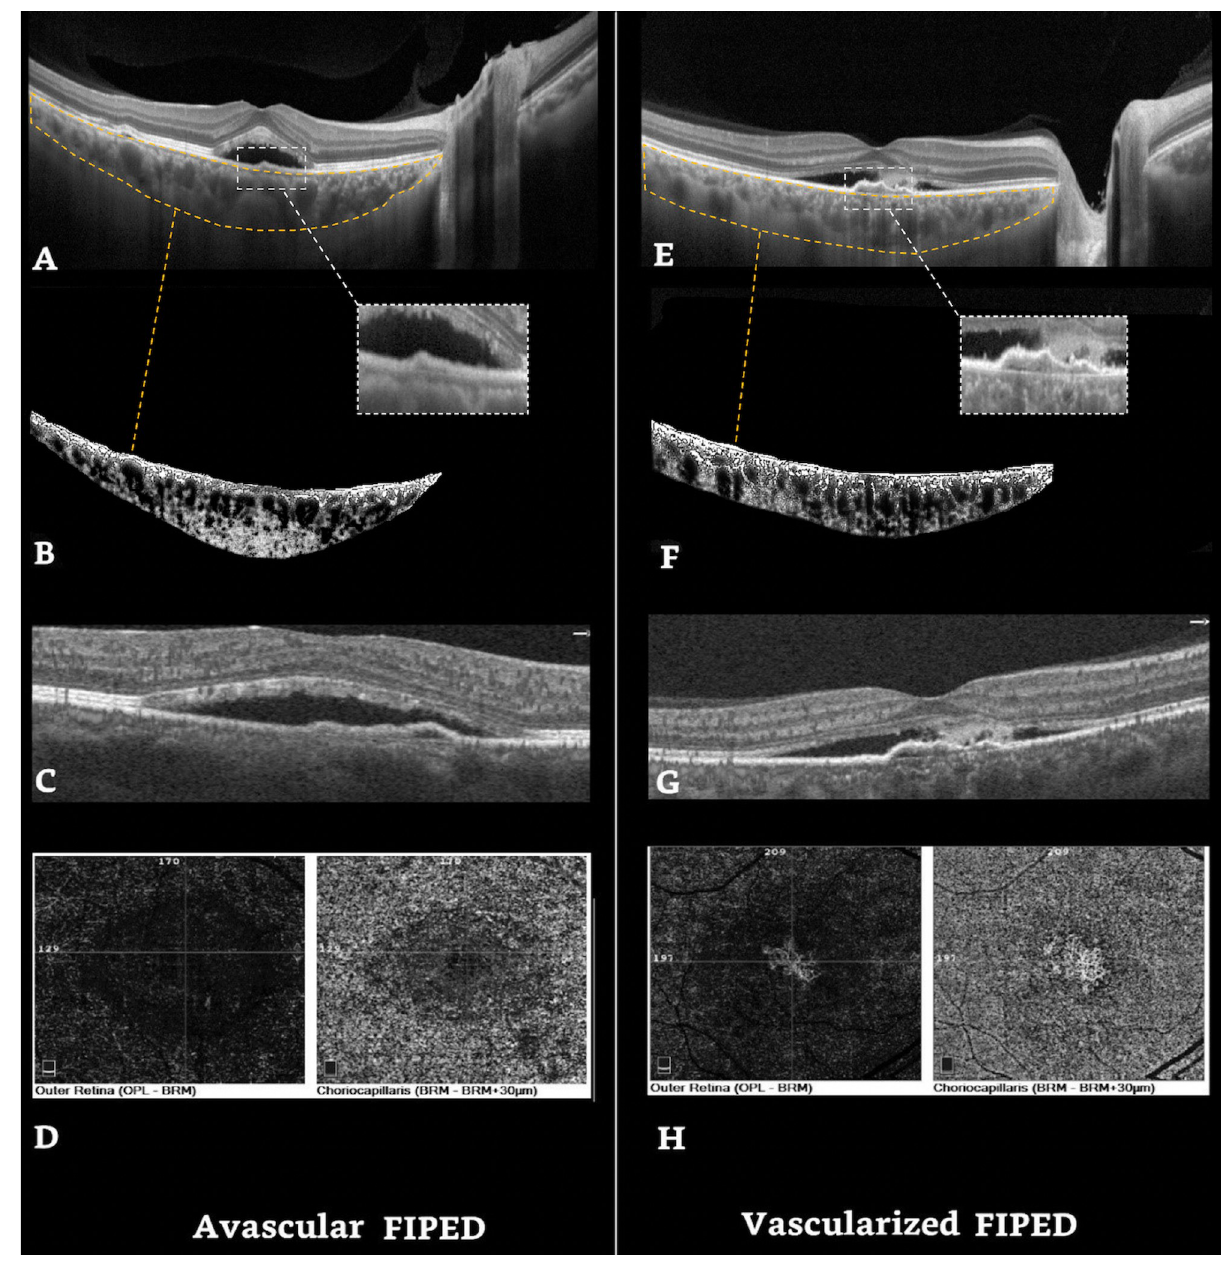
Fig 1. Right eye EDI-OCT and OCTA images of chronic CSC in a patient with avascular FIPED (A-D) and a patient with vascularized FIPED (E-H). A and E show corresponding EDI-OCT scanning foveal area, B and F show corresponding choroidal vasculature overlay performed with the Sonoda’s technique. C and G show the flow overlay of the OCTA B-scan in the foveal area, G illustrates the flow in the FIPED area. D and H show OCTA enface images, outer retina, and choriocapillaris slabs. H reveals the CNV in both slabs in vascularized FIPED. FIPED: Flat irregular pigment epithelial